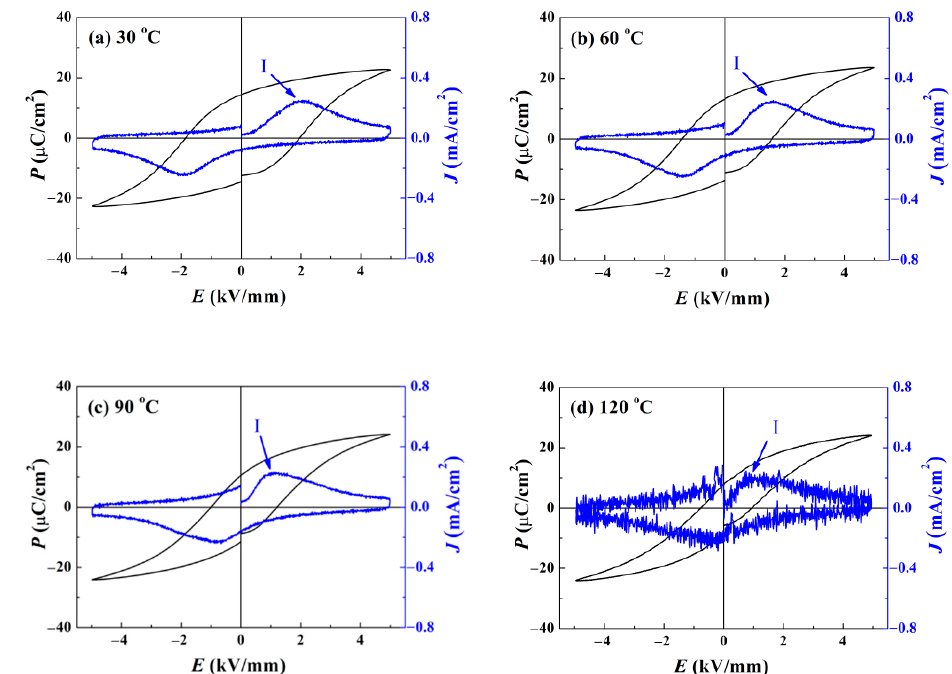
Figure 8. Temperature dependent polarization–electric field P – E hysteresis curve for the component x = 0.3: ( a ) 30 °C, ( b ) 60 °C, ( c ) 90 °C, and ( d ) 120 °C. Compared to pure BNKT-BT ceramic at the same temperature, no other evidences of the notable changes of the ergodic degree were detected except for the shift of Peak I towards the low electric field direction, which demonstrates an improved temperature stability.